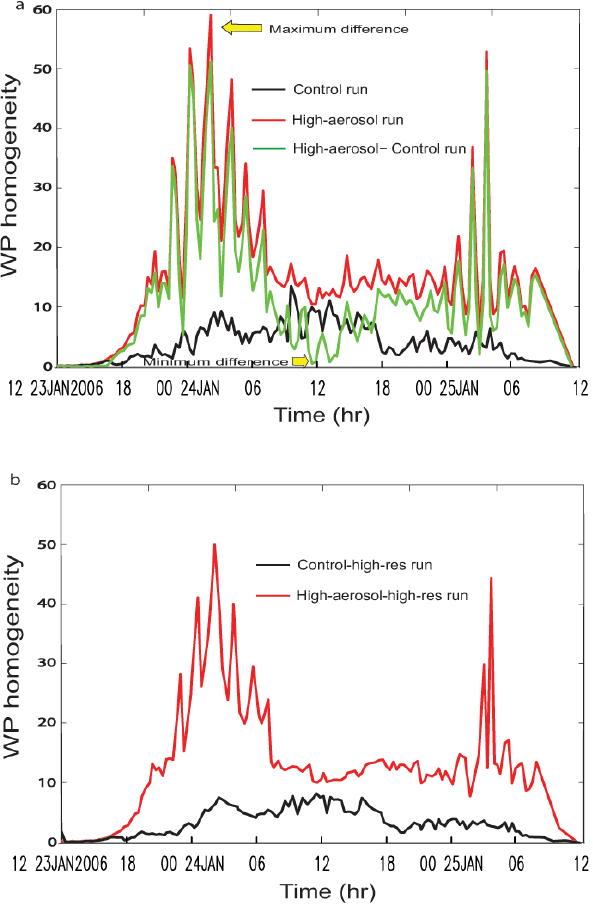
Fig. 6. Time series of the WP homogeneity (a) for the control and high-aerosol runs and (b) for the control–high-res and high-aerosol– high-res runs.